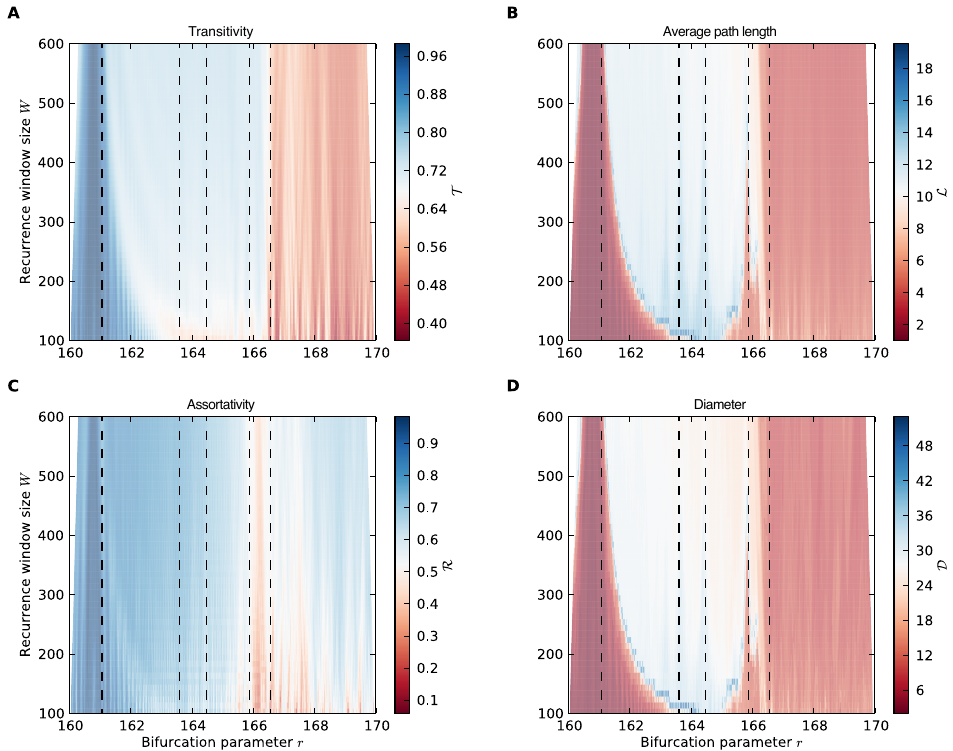
Fig. 8. (A) Transitivity T , (B) average path length L , (C) assortativity R , and (D) diameter D for varying recurrence window size W for the Lorenz system (Eq. (19)) with drifting bifurcation parameter r (see text) and initial condition ( x 0 ,y 0 ,z 0 )=(10 , 10 , 10) . Because we are interested in the performance of our method for scalar time series, we chose the x -component of the trajectory sampled with sampling time ∆ t =0 . 05 and embed it with embedding dimension m =3 and delay τ =15 . W was varied linearly in the interval [100 , 600] , the recurrence window step size was fixed to ∆ W =10 samples. We varied the recurrence threshold ε to yield a fixed edge density ρ =0 . 05 (Donner et al., 2010b). Vertical dashed lines indicate the critial values of r discussed in the main text.